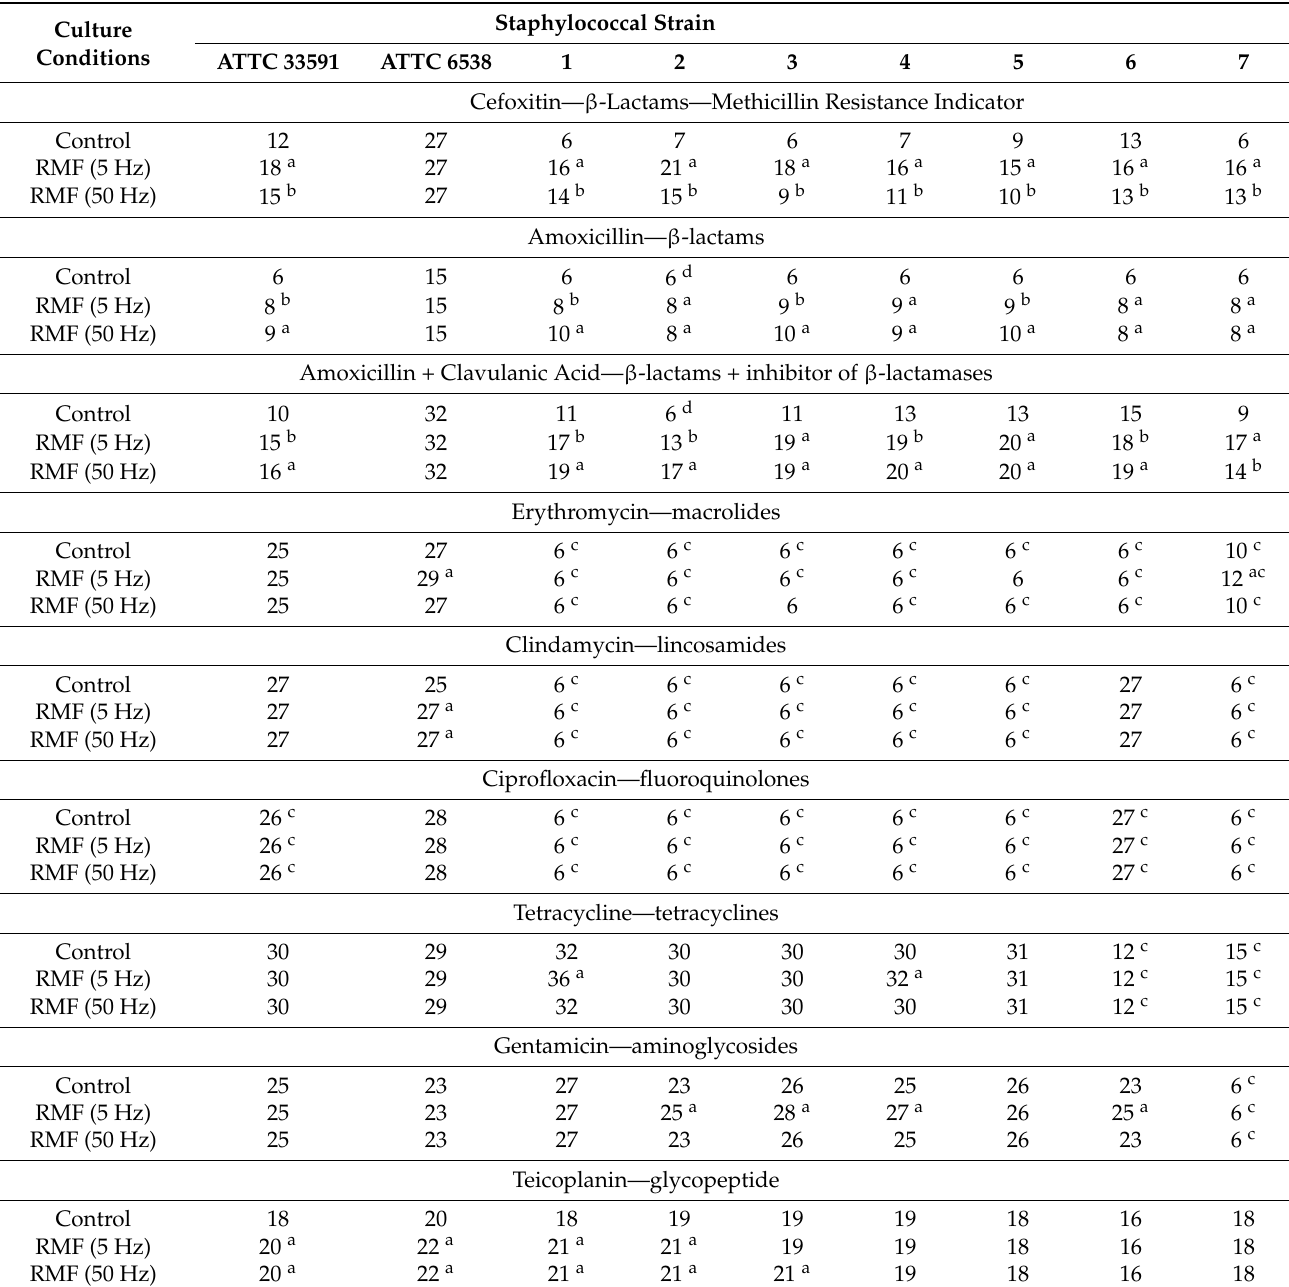
teicoplanin (a representative of glycopeptides). The differences between inhibition zones around gentamicin discs were found for four MRSA strains, whereas around teicoplanin discs for five strains, including the MSSA. The diameters of inhibition zones were larger by 2–3 mm as compared to the control. Moreover, in the study with gentamicin, the differences were only observed in the cultures exposed to RMF 5 Hz. Table 1. Growth inhibition zones (mm) of RMF-exposed staphylococcal strains around antibiotic